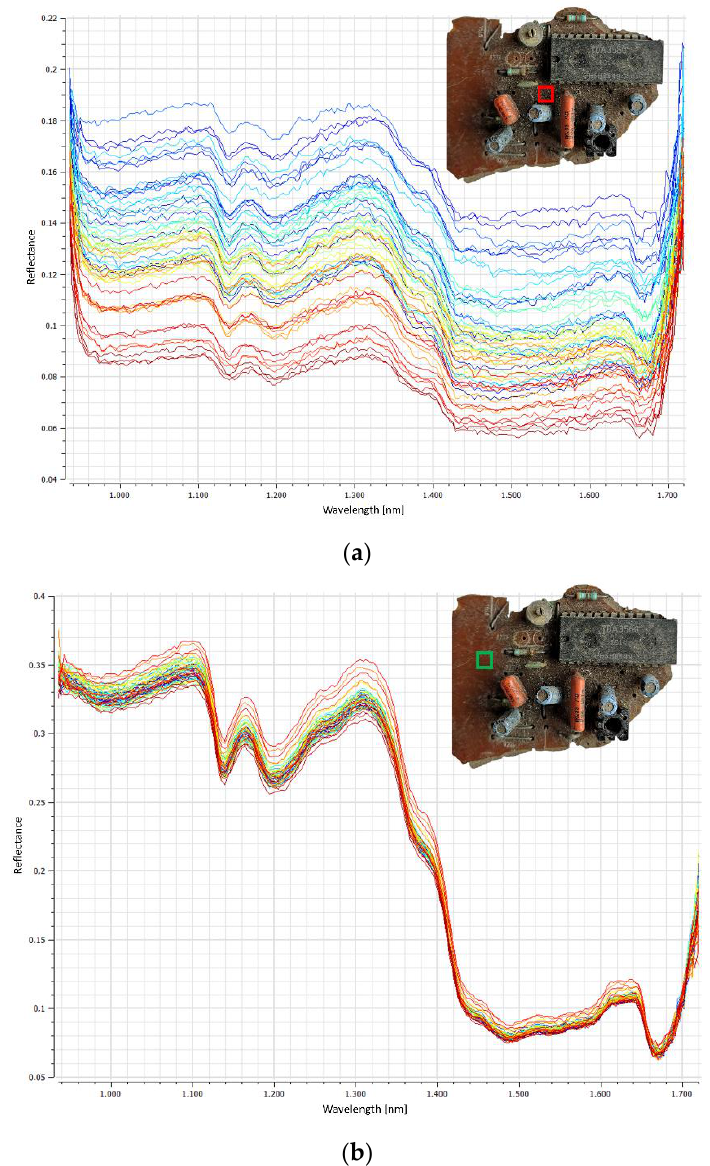
Figure 17. Influence of dirt on the reflectance of spectral signatures. ( a ) Spectra of a heavily polluted area (red box). ( b ) Spectra of areas without dirt (green